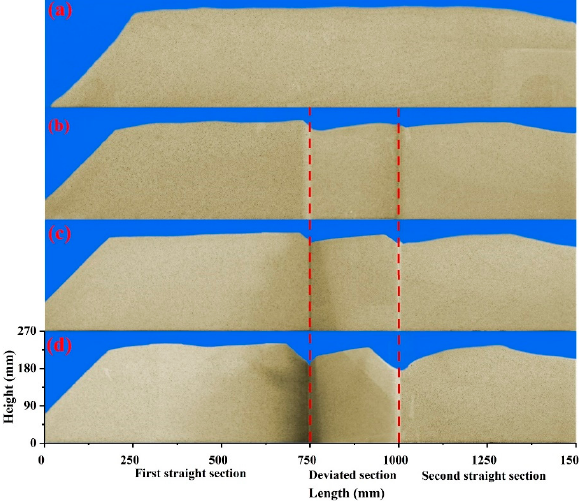
Figure 12. Snapshots of 40/70 mesh sand dunes in four channels at the stable status at Re = 946, S = 0.05, and L 1 /L = 0.5, front view: ( a ) The straight channel, θ = 180°; ( b ) The curving channel, θ = 135°; ( c ) The curving channel, θ = 90°; ( d ) The curving channel, θ = 45°.